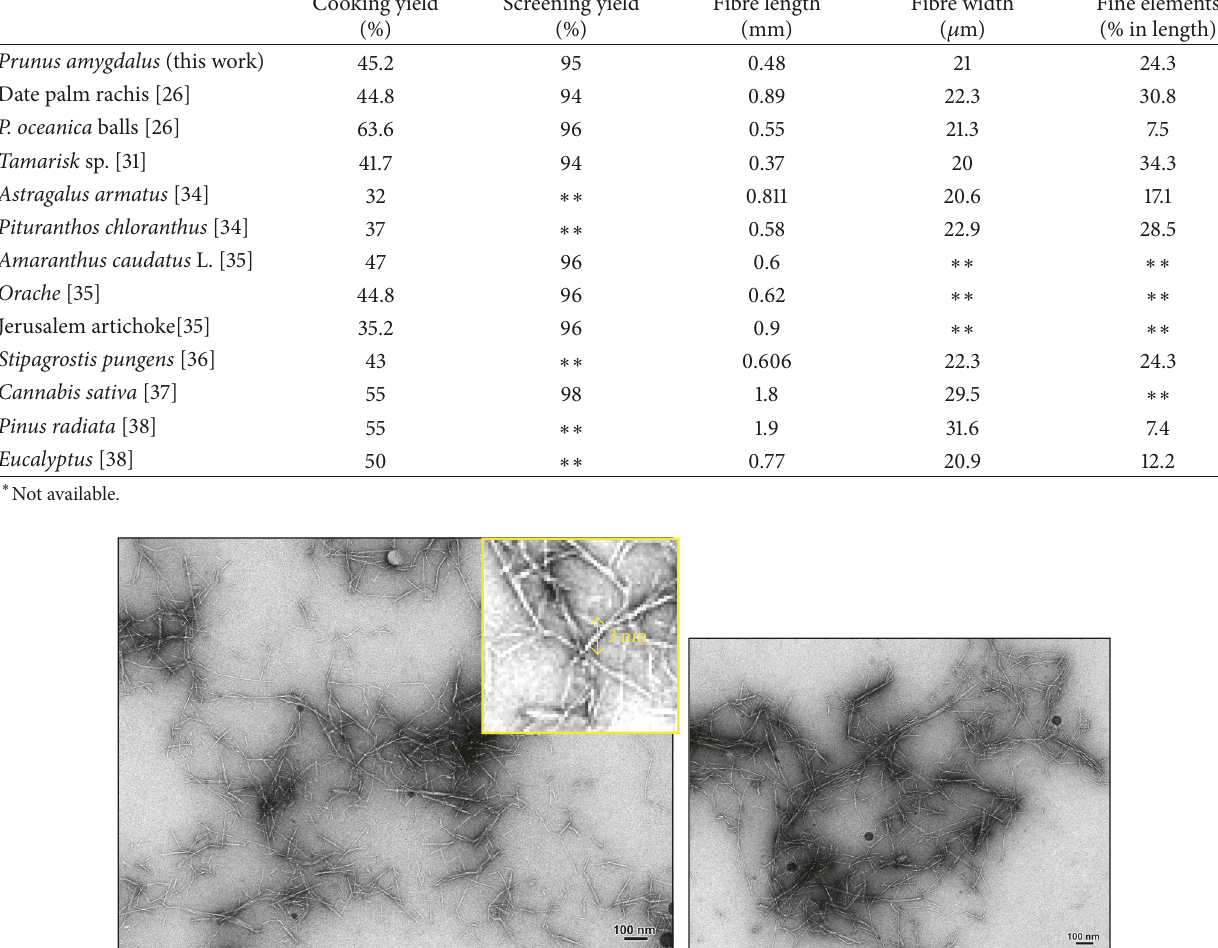
Table 1: The main properties of the pulps of Prunus amygdalus and others plants. Cooking yield Screening yield Fibre length (%)